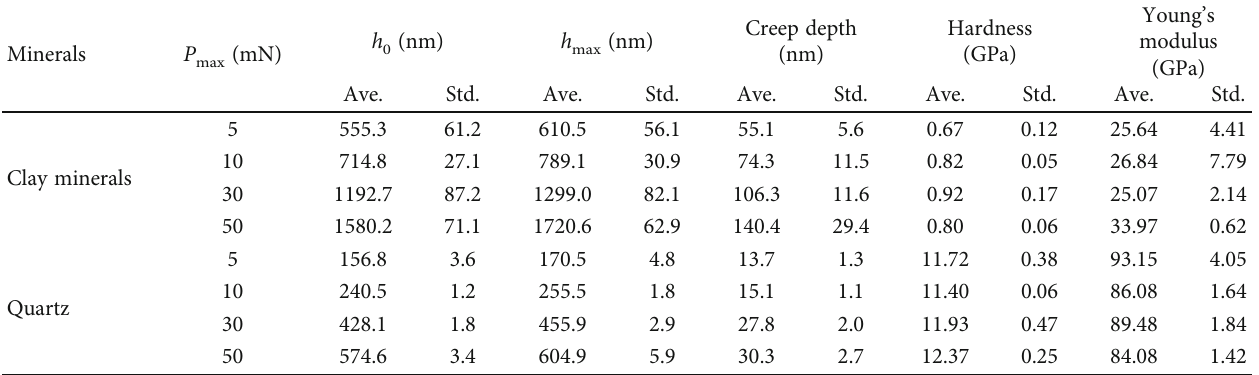
Table 1: Indentation data related to quartz and minerals in shale.